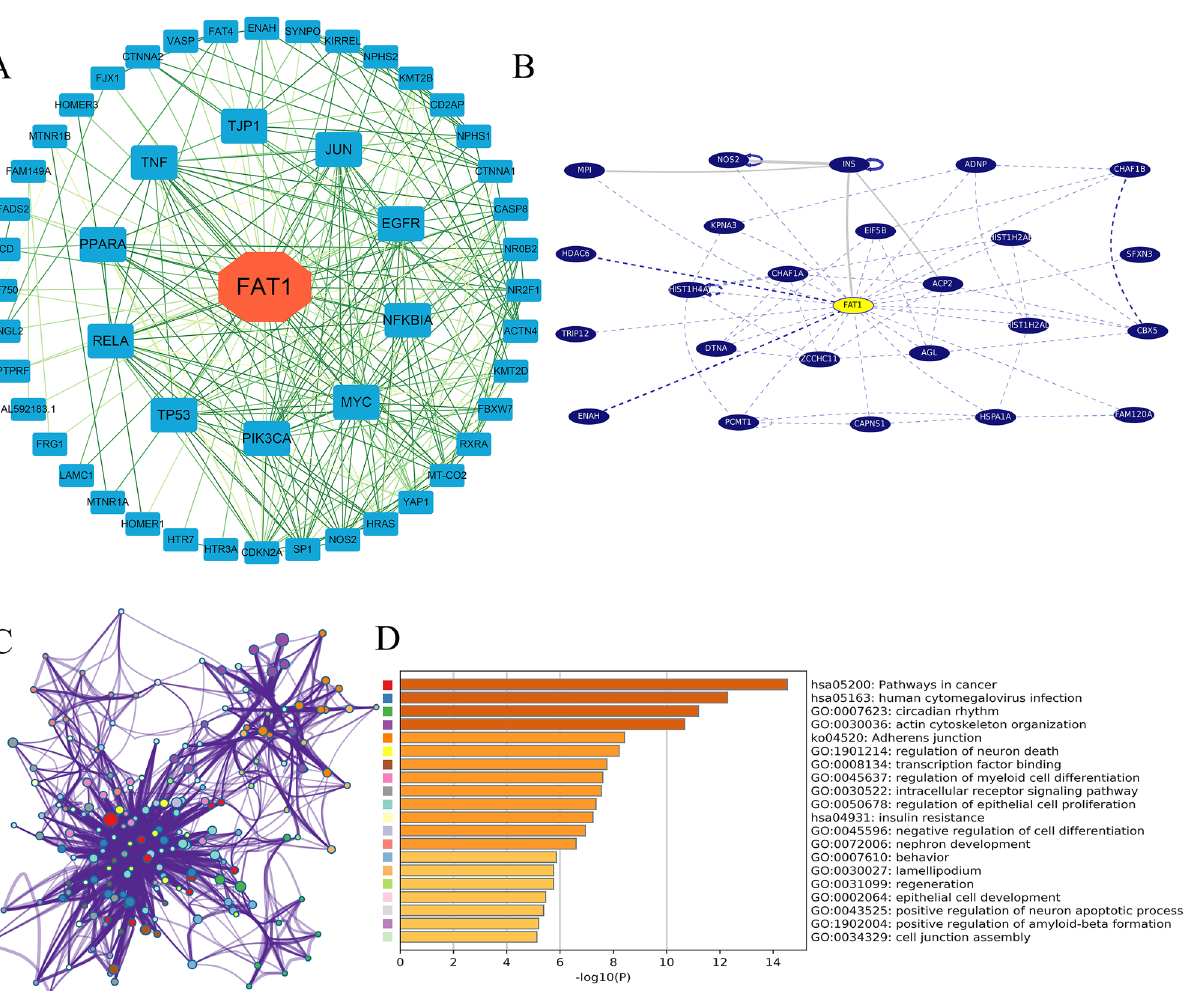
Figure 6. FAT1 protein interaction network and pathway enrichment analysis. ( A ) Protein–protein interaction network of FAT1 in the STRING database, the darker color of the linkage represents stronger correlation, active interaction sources including text mining, experiments, databases, co-expression, neighborhood, gene fusion, co-occurrence, the minimum required interaction score is 0.4 (medium confidengce). ( B ) The top 24 genes with the strongest correlation with FAT1 in UCSC, only FAT1-interacting genes and only the most-mentioned/most- curated interactions, Solid grey lines—only text-mining support for this interaction, with the thickness of the line indicating the number of articles supporting it. Dashed blue lines—at least one curated database supports this interaction. Dark blue—the information is derived from a paper describing fewer than ten interactions. Light blue—the information is derived from a high-throughput paper describing more than ten interactions. Solid blue lines—databases and text mining support this interaction and are colored by support. The top 20 results of KEGG and GO enrichment analysis of FAT1 and its interacting proteins, ( C ) cluster network plot, ( D ) histogram, different colors represent different pathways and biological processes (The color of panel C corresponds to the color in panel D), “Log10 (P)” is the p-value in log base